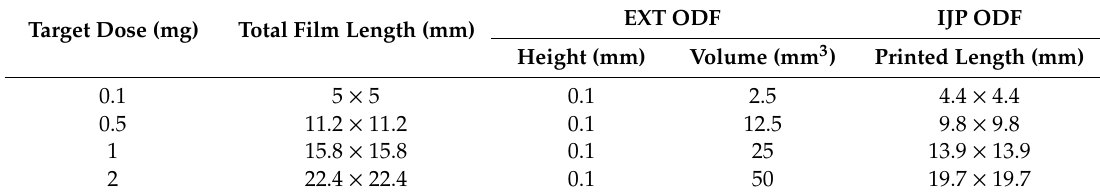
Table 1. Designed geometries for the